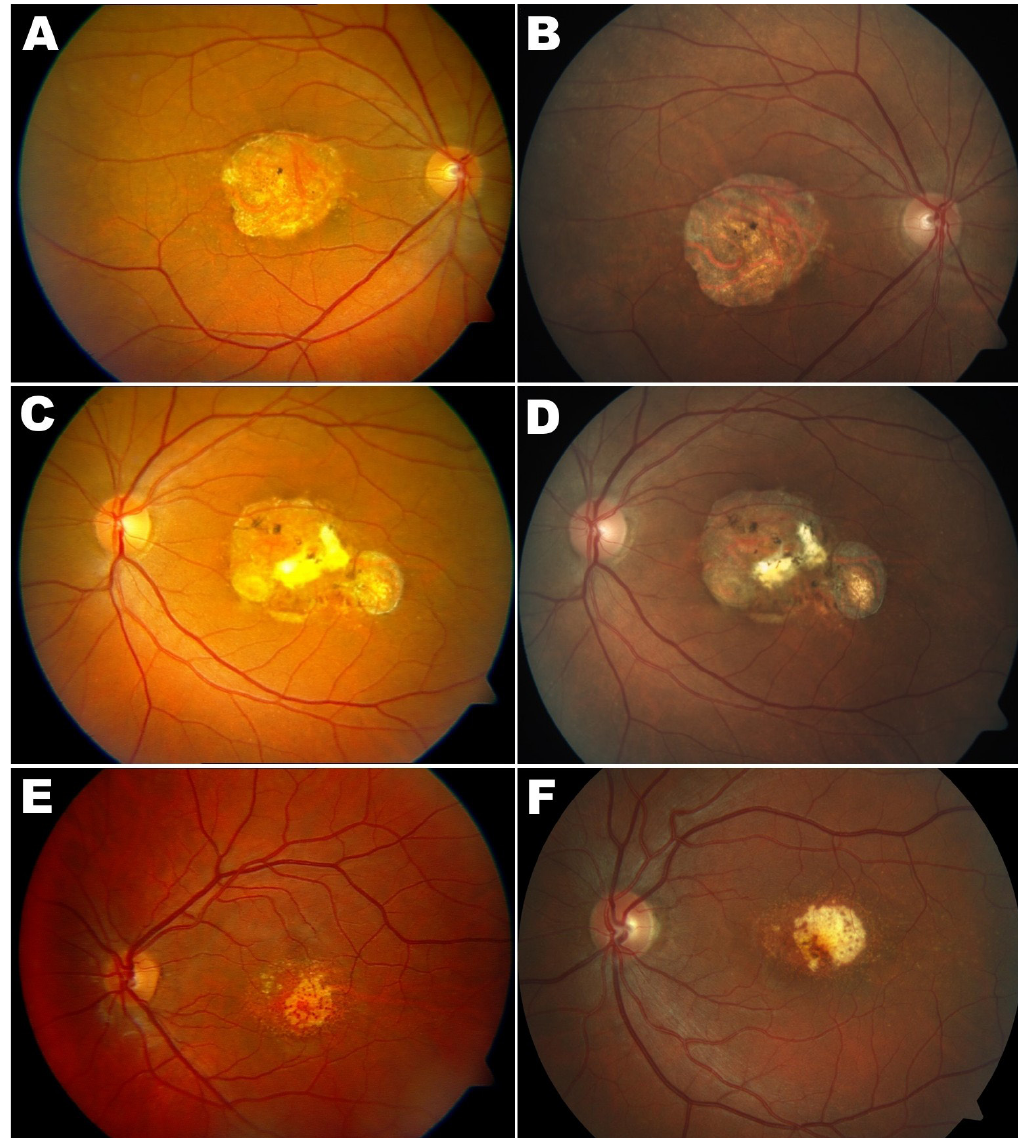
Fig.1 A-D. Patient 1. The fundoscopy revealed large bilateral lesions of the RPE affecting the macular area, long-term stable findings, worse left eye. 1A. right eye 15 years before and 1B. right eye, current finding. 1C. left eye 15 years before and 1D. left eye, current finding. 1E. Patient 3. Fundus photography of the left eye. Beaten- bronze-like pigment changes in the macula. 1F. Patient 4. Fundus photography of the left eye. Yellowish-white foci encircled by hypopigmented halos in the macula, surrounded by